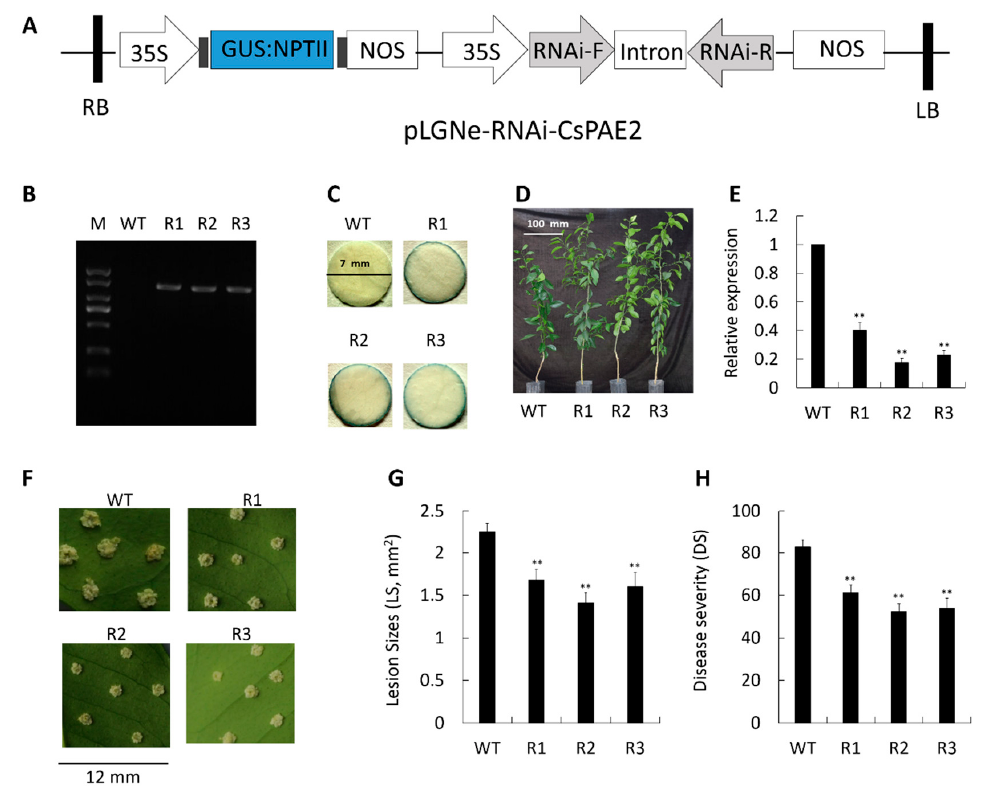
Figure 6. Assessment of Xcc responses in CsPAE2 knockdown plants and WT plant. ( A ) Plasmid pLGNe- CsPAE2 -RNAi used for RNAi assay. NPTII, NptII gene; NOS, Nos terminator; GUS, glucuronidase; LB: left border; RB: right border. ( B ) PCR-mediated validation of transgenic plants. ( C ) GUS staining-mediated validation of transgenic plants. ( D ) The phenotypes of transgenic plants. Scale bar = 100 mm. ( E ) The expression of CsPAE2 in the indicated plants was measured via qRT-PCR, with CsActin used for the normalization. At 10 dpi, disease symptoms on the leaves of WT and transgenic plants inoculated with Xcc were assessed ( F ), and lesion size (LS) ( G ) and disease severity (DS) ( H ) were assessed. In ( F ), the scale bar = 12 mm. WT plants served as controls for statistical testing. Data are means ± SEs ( n ≥ 3). Duncan’s multiple range test was used to compare data of OEs and WT, with three biological replicates per sample ( ** p < 0.01).